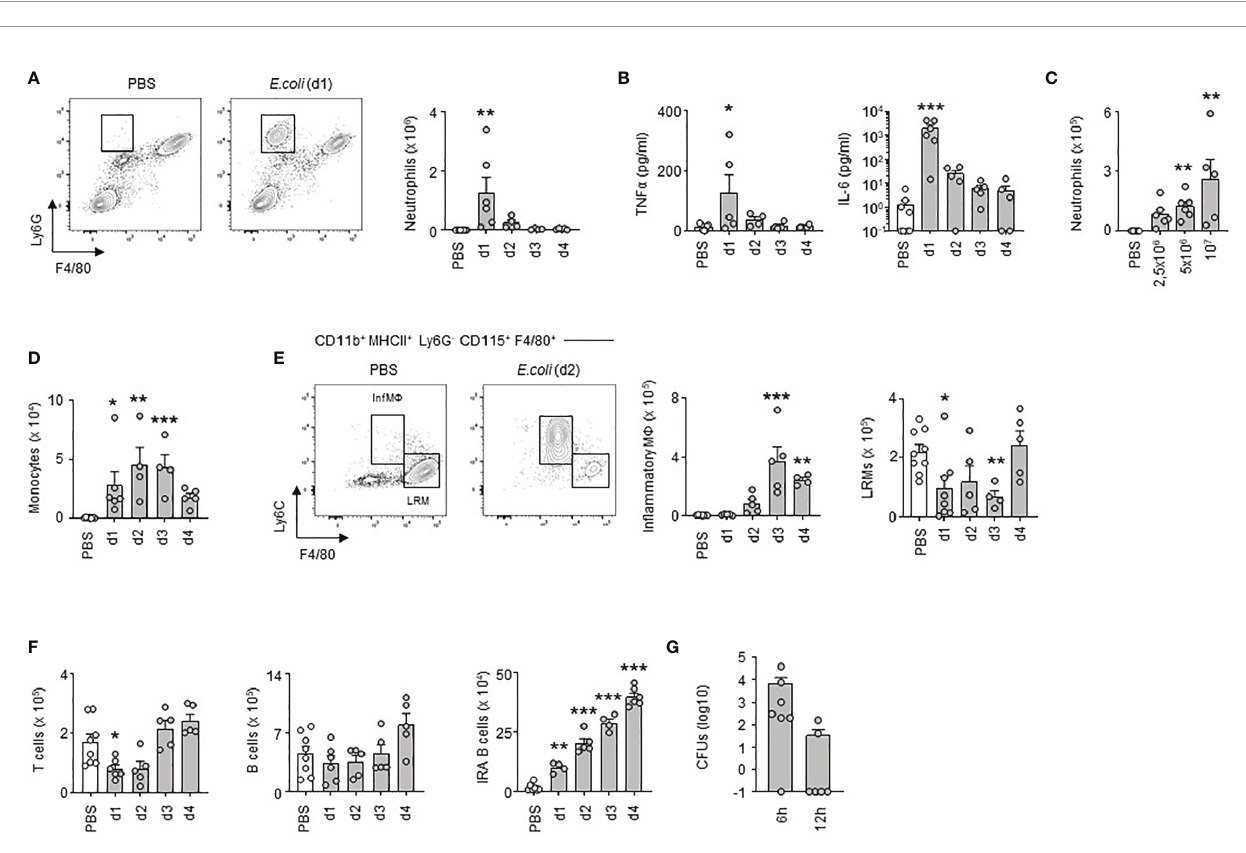
FIGURE 2 | Early in fl ammation of pleural space upon E. coli airway infection. (A) Representative dot plots and enumeration of neutrophils in pleural space 1, 2, 3 and 4 days after i.t. infection of 5x10 6 CFU of E. coli or PBS (n=5-7 mice per time point). (B) Levels of TNF a and IL-6 in pleural space 1, 2, 3 and 4 days after i.t. infection of 5x10 6 CFU of E. coli or PBS (n=5-7 mice per time point). (C) Enumeration of neutrophils in pleural space 4 days after i.t. infection of 0, 2.5, 5 or 10x10 6 CFU of E. coli (n=5-6 mice). (D – F) Enumeration of monocytes (D) , in fl ammatory and large resident macrophages (E) , T cells, B cells and IRA B cells (F) in pleural space 1, 2, 3 and 4 days after i.t. infection of 5x10 6 CFU of E. coli or PBS (n=5-7 mice per time point). (G) Number of CFUs in pleural space fl uid 6h and 12h after i.t. infection of 5x10 6 CFU of E. coli (n=6). Data are pooled data from at least 2 independent experiments. Data represent mean ± S.E.M. and were analyzed by the Dunnett ’ s multiple comparisons test. *p<0.05; **p<0.01;